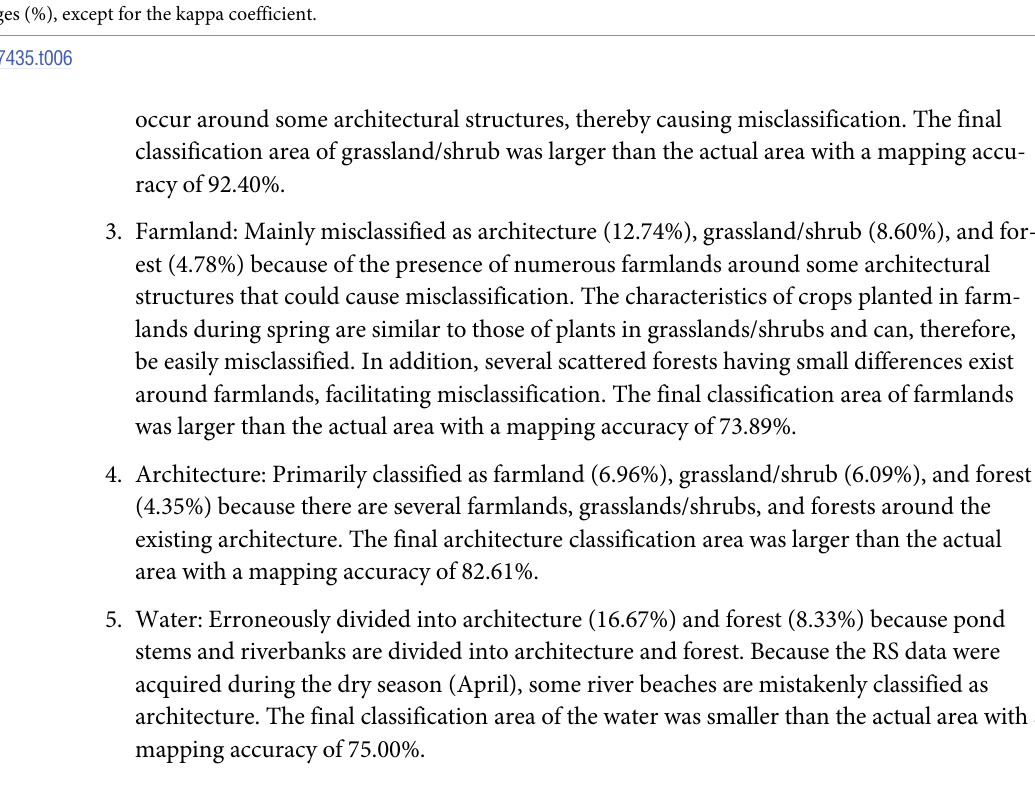
Table 6. Accuracy of the object-oriented classification of Longmen Tianguan. Type Forest Grassland/shrub